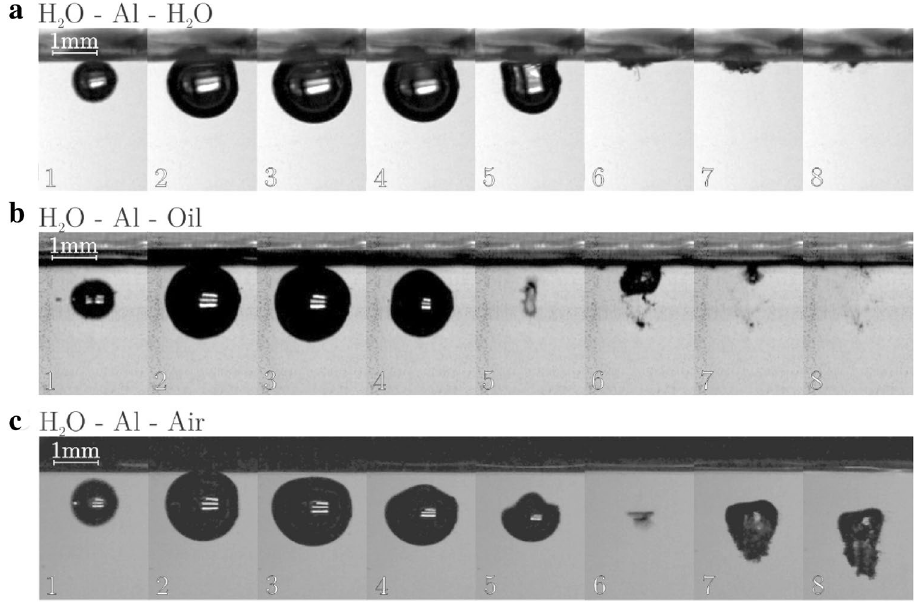
Figure 4. Typical bubble evolution for ( a ) water–Al–water, ( b ) water–Al–oil, ( c ) water–Al–air interface at γ =